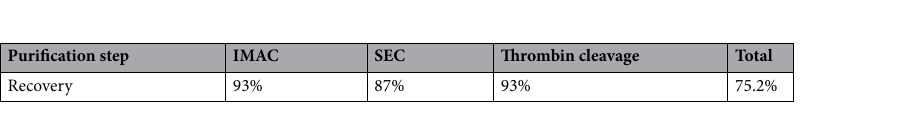
Table 2. Percentage recovery for individual purification steps and the complete purification